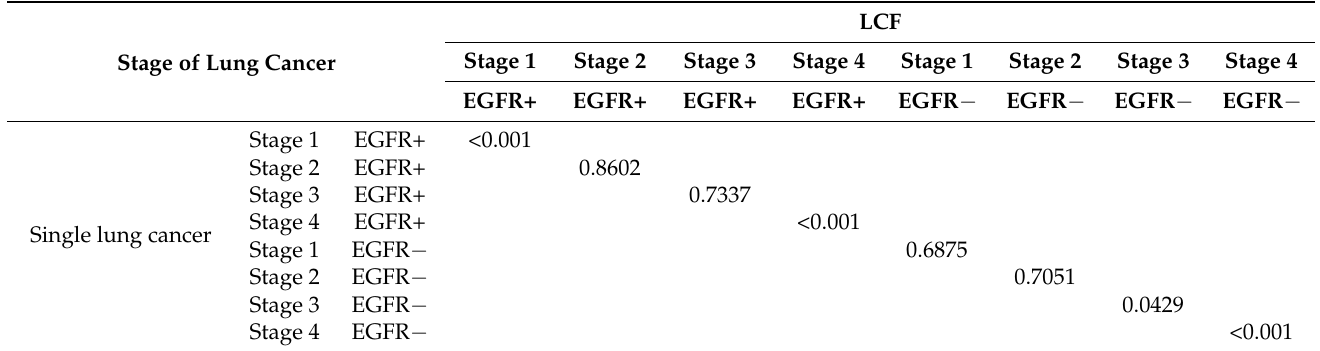
Table 5. Kaplan–Meier analysis of overall survival among different stages of patients with epider- mal growth factor receptor (EGFR) mutations.